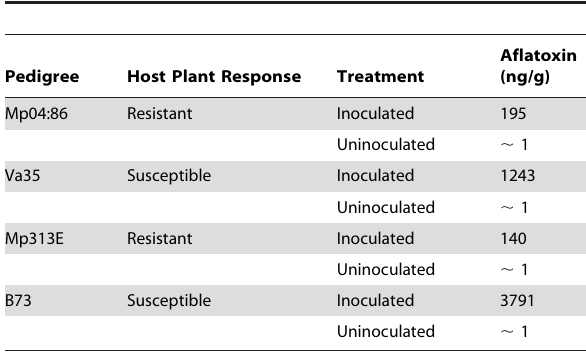
Table 1. Kernel aflatoxin levels in the four maize inbred lines used for the DNA microarray